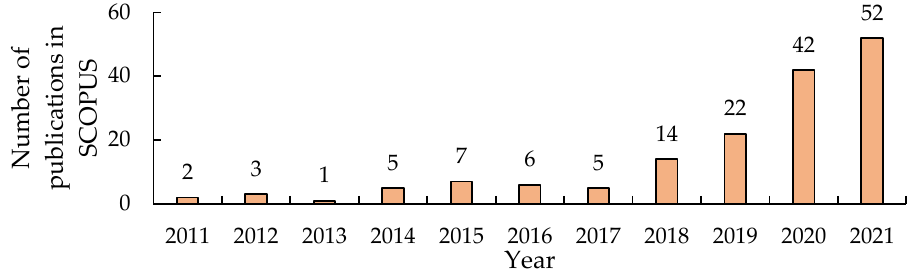
Figure 1. The growth of low-cost sensors in civil engineering sector.